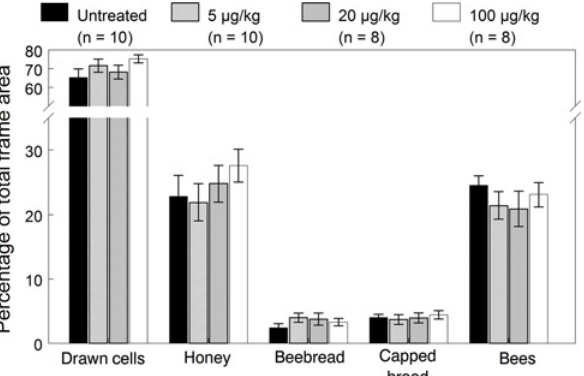
Fig 3. Colony performance endpoints (mean ± SE) of the 2009 colonies recorded on October 6 prior to overwintering (two months after